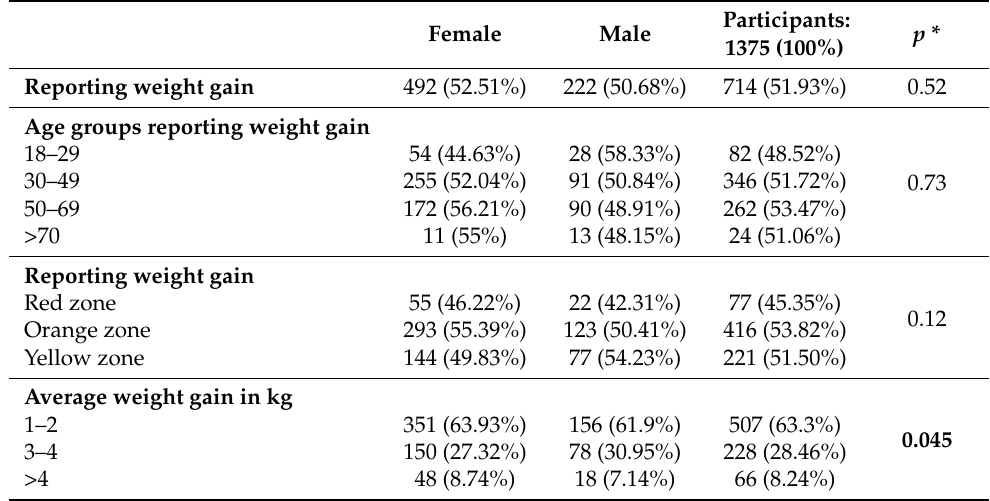
Table 3. The reported weight gain during the 60-day lockdown.